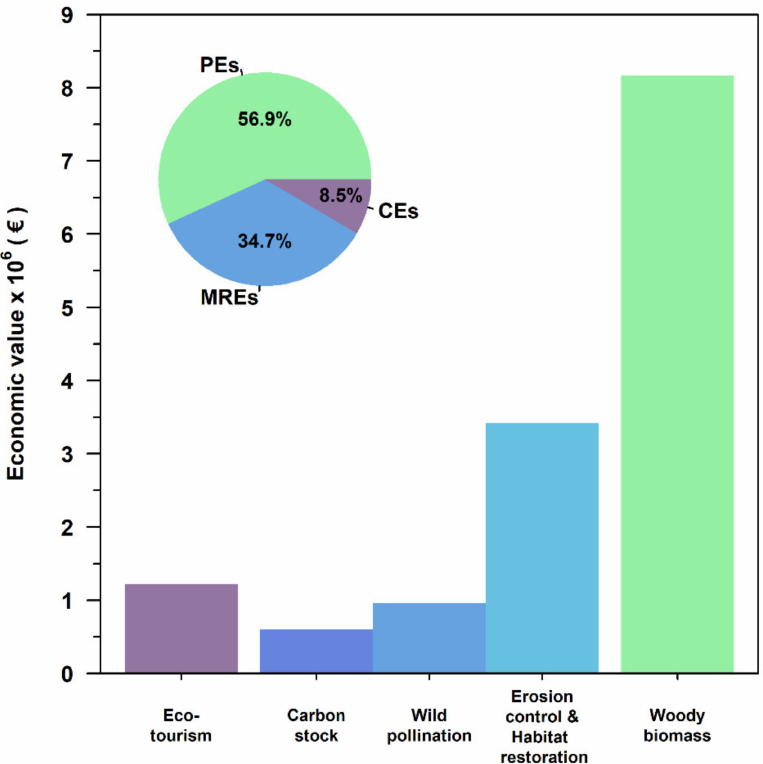
Figure 3. Value of economic losses resulting from wildfire-related damage to ecosystem services. In the inset graph, PEs correspond to provisioning services, MREs to regulation and maintenance services, and CEs to cultural services.